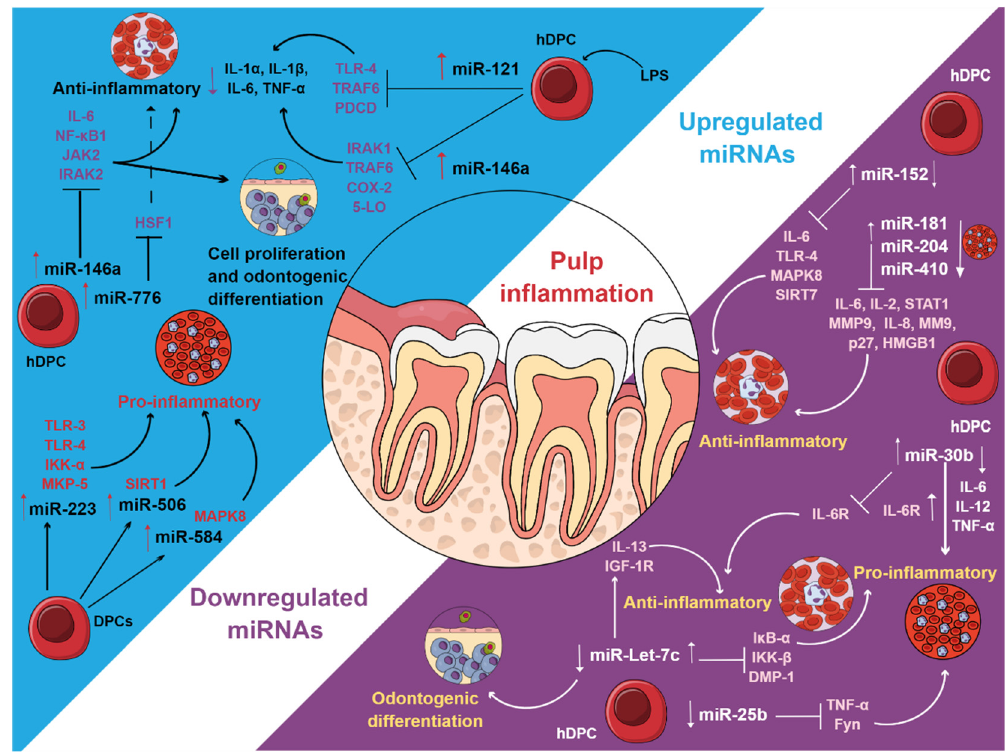
Figure 3. Upregulated and downregulated miRNAs in pulp inflammation. Figure created in MindtheGraph by Muñoz- Carrillo et al., 2021.